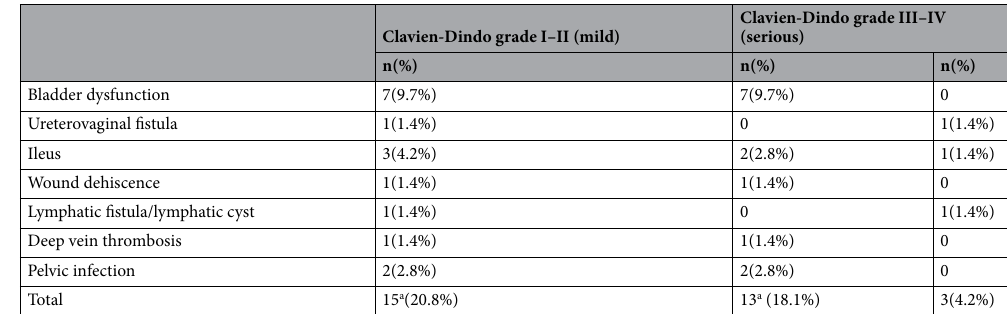
Table 3. Hospital- and patient-reported postoperative complications (no. of surgery = 72). SPSS 17.0 (IBM Corp, Armonk, NY, USA) was used for statistical analysis.The website of SPSS is https:// www. ibm. com/ cn- zh/ analy tics/ spss- stati stics- softw are. a One patient had two complications